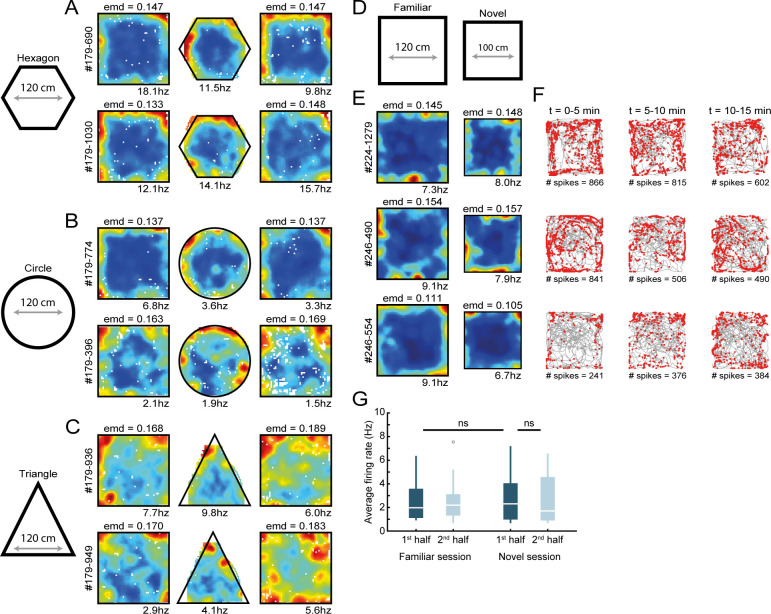
RSC border cell firing under novel conditions and different arena shapes.(A–C) Recordings were performed across different shapes of environments. Shown are rate maps of border cells that fired at the edge of a squared arena, and cells maintained their firing to the borders when the outer walls were changed to form a hexagonal (A), circular (B), or triangular (C) shape. (D) Several experimental sessions were performed under novel conditions, where animals had never visited neither this maze nor the recording room before. (E) Spatial rate maps of three typical RSC border cells that showed no qualitative differences between a familiar and novel maze. (F) Trajectory spike plots of the novel session for the same cells shown in (E), subdivided into blocks of 5 min. (G) RSC border cells fired with a similar spiking rate already from the beginning of the session, with no significant differences between the familiar and novel sessions. Wilcoxon signed-rank test.